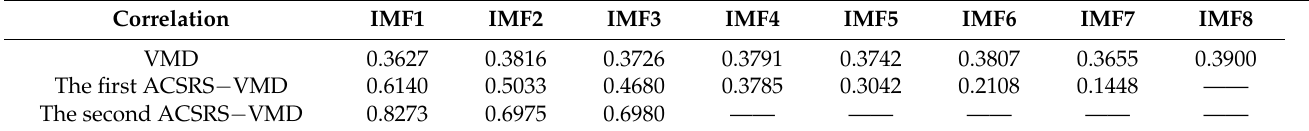
Table 5. Correlation values of different IMF component signals.